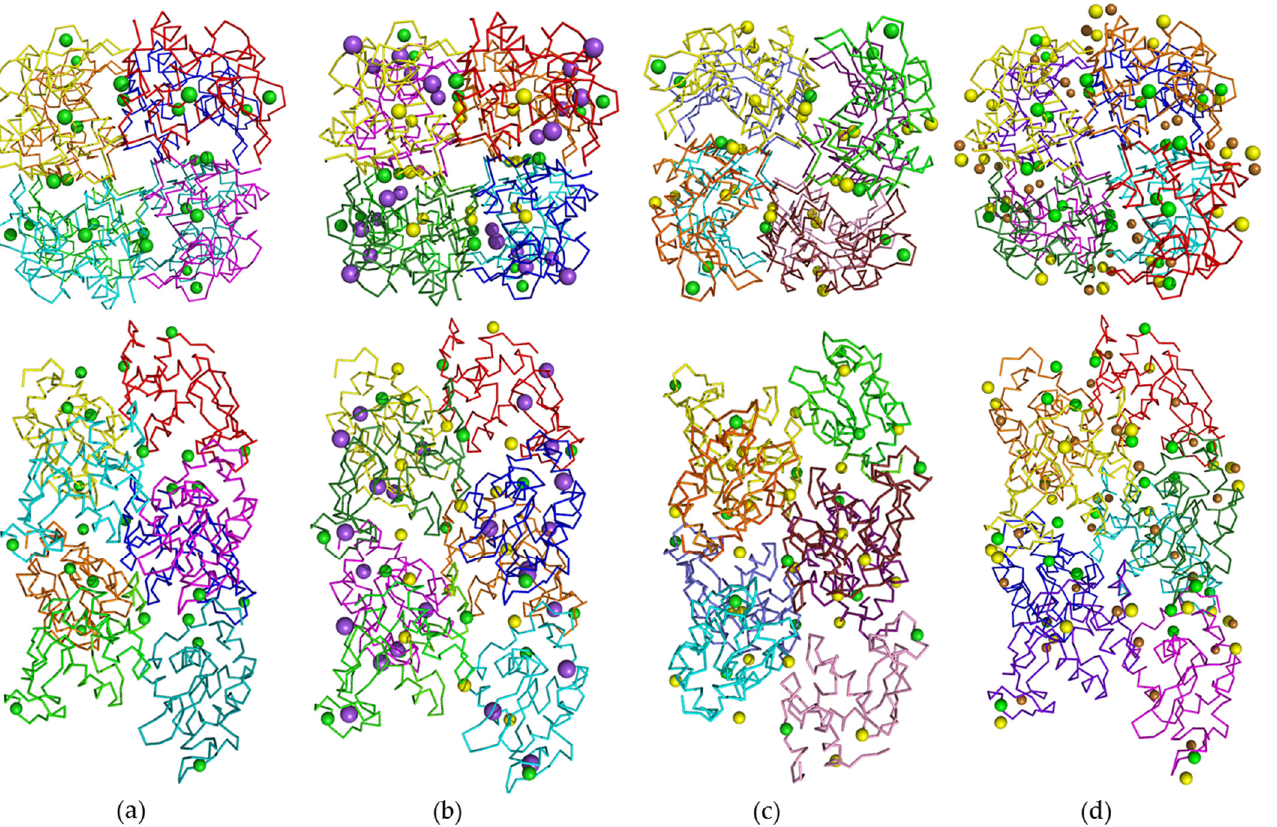
Figure 10. The distribution of metal and chloride ions in the crystal lattice of lysozyme octamers across (top) and along (bottom) the 4-fold axis. Octamers structures relate to crystals grown in solutions with different precipitants: LiCl ( a ), NaCl ( b ), KCl ( c ) and CuCl 2 ( d ). All precipitant ions are presented as spheres. Chlorine ions common for all considered structures are green, specific chlorine ions are yellow, sodium ions are purple and copper ions are orange.